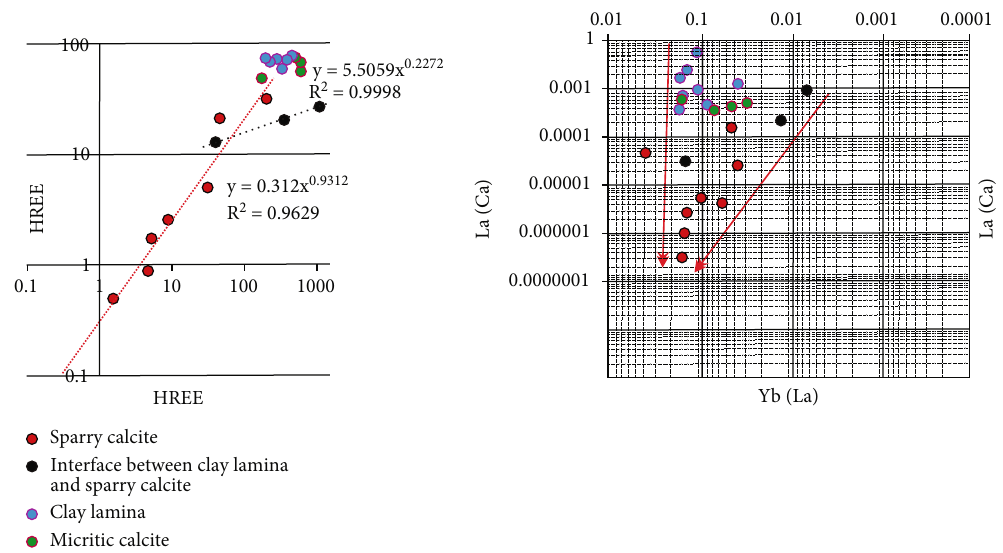
Figure 8: LREE – HREE and La/Ca – Yb/La scatter plots of laminated argillaceous sparry